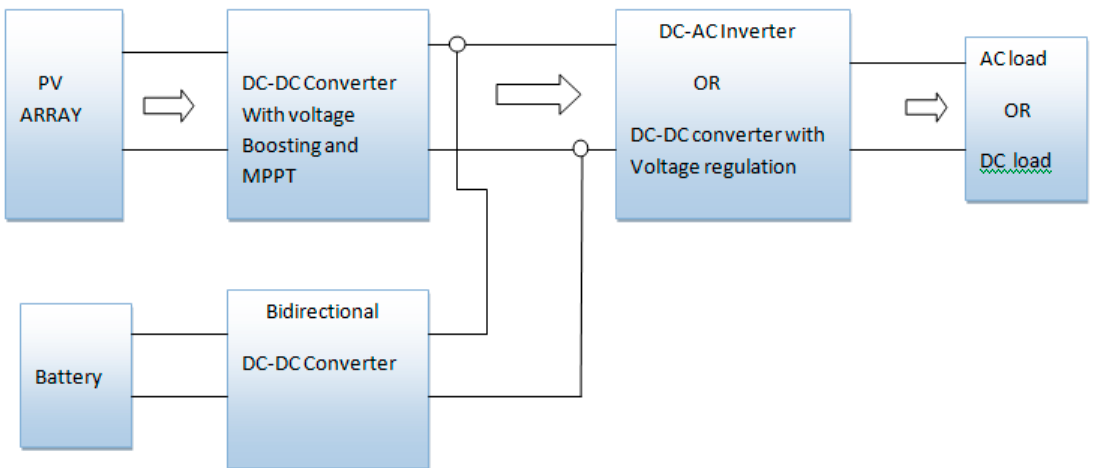
Figure 1. Block diagram of stand-alone PV power systems [7].